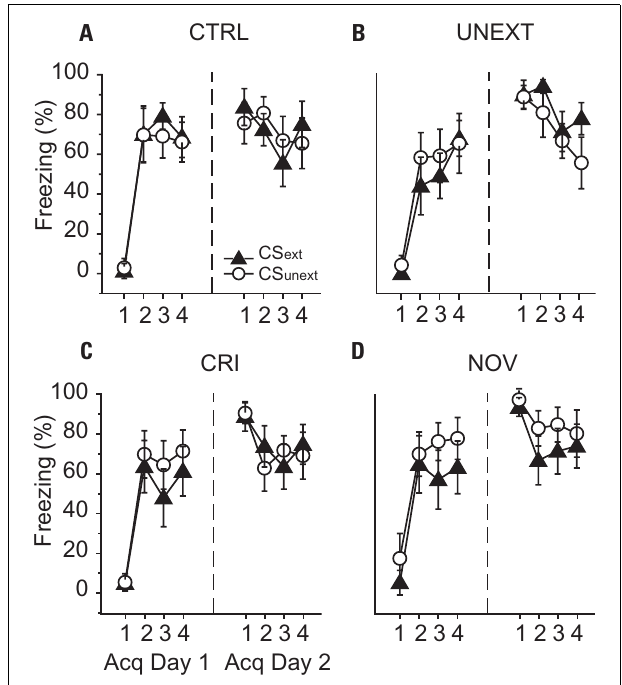
FIGURE 2 | Freezing during training sessions. Animals were trained to fear a tone and a light CS during two acquisition days consisting of four pairings of each CS with the US on each day (for a total of eight CS–US pairings per day).The y -axis of each graph indicates percentage of time spent freezing (freezing, %) to CS Ext and CS Unext (light or tone, counterbalanced) during each conditioning trial. (A) CTRL group, (B) UNEXT group, (C) CRI group, (D) NOV group.